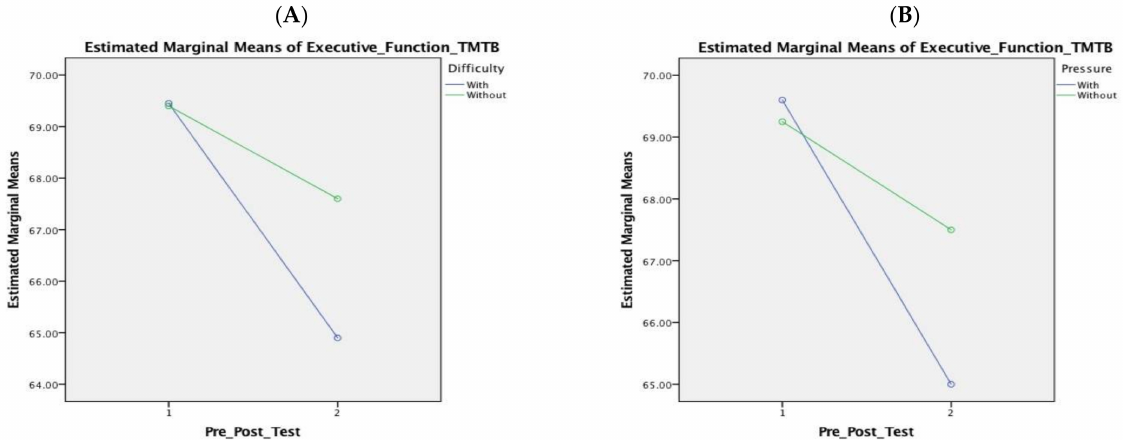
Figure 13. The graph of two-factors interaction in TMT-B. Figure ( A ) shows the interaction of pre/post-test * difficulty; Figure ( B ) shows the interaction of pre/post-test * pressure. Note: pre/post- test (the horizontal axis), pre-test = 1, and post-test =